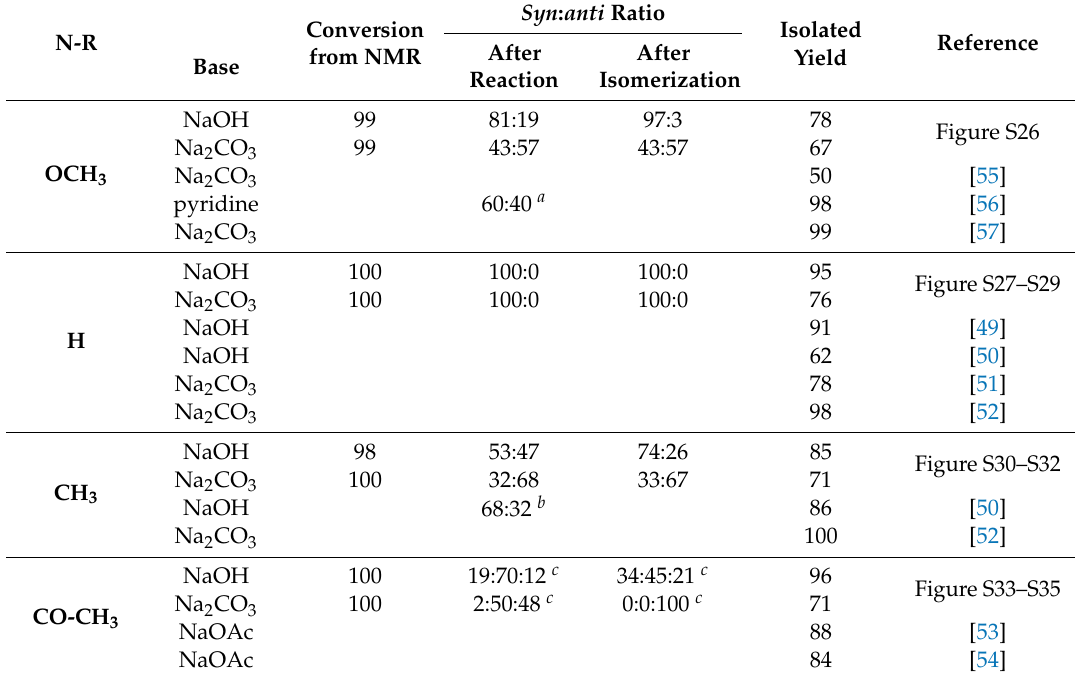
Table 2. Conversions, isolated yields and syn : anti oxime ratios immediately after reaction and after isomerization. The basic experimental conditions, together with yields reported in relevant literature are provided for comparison. In a reference column, either a link to corresponding figures in the supplementary information (NMR spectra, Figures S25–S35), or a literature reference is provided. For all experiments, the conditions for entries 3 or 7 in Table 1 (when the reaction was performed with NaOH or Na 2 CO 3 , respectively), were